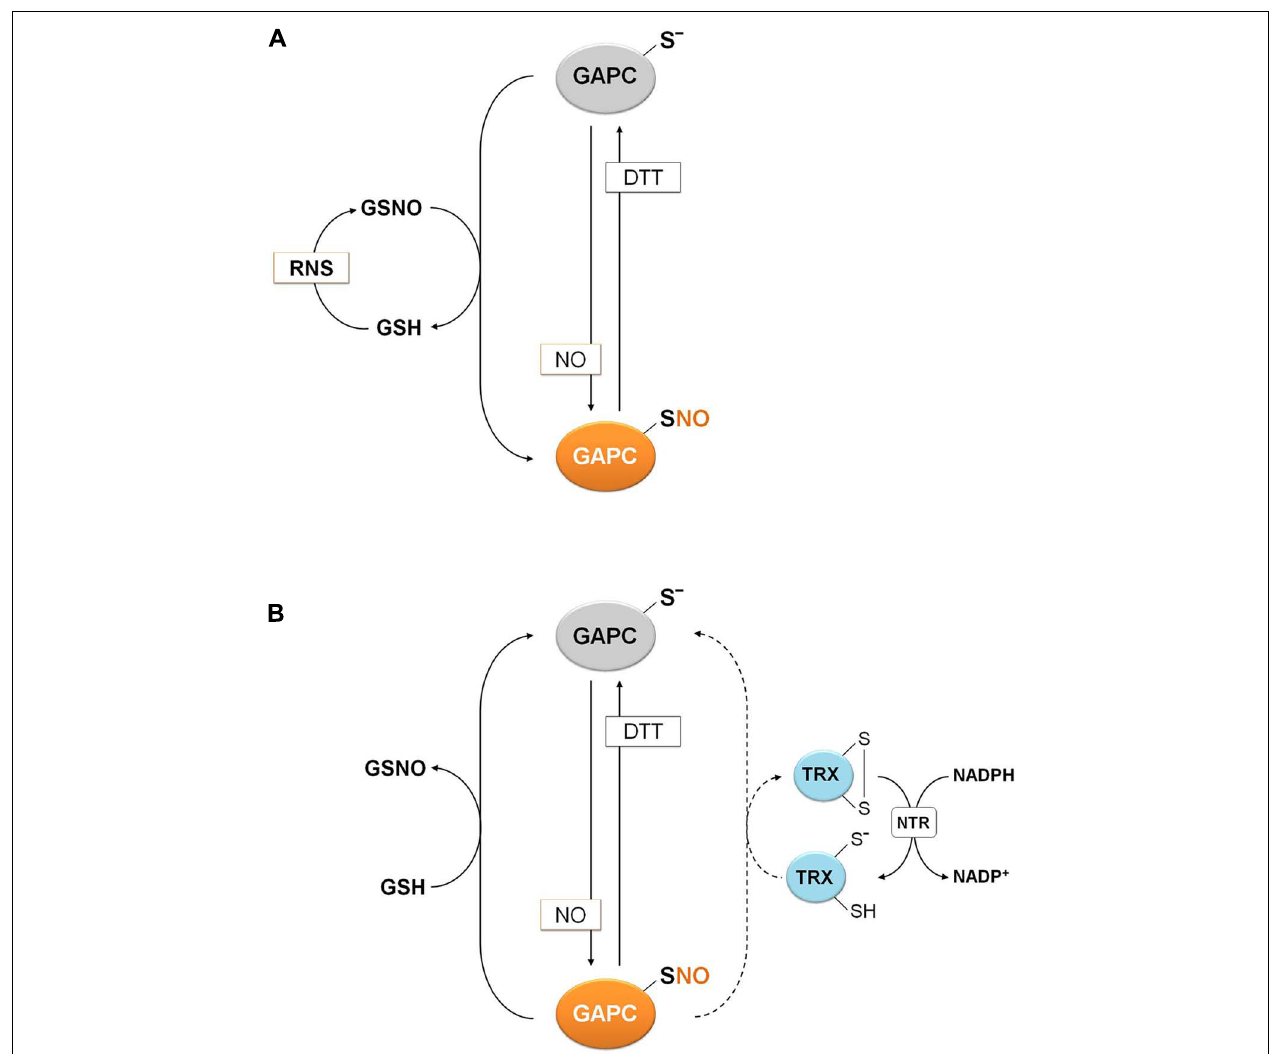
FIGURE 6 | Molecular mechanisms of plant GAPC nitrosylation and denitrosylation. (A) Nitrosylation of plant GAPC. Plant GAPC undergoes reversible S-nitrosylation in the presence of NO donors or trans-nitrosylation by GSNO with concomitant release of GSH. GSNO can be generated by the